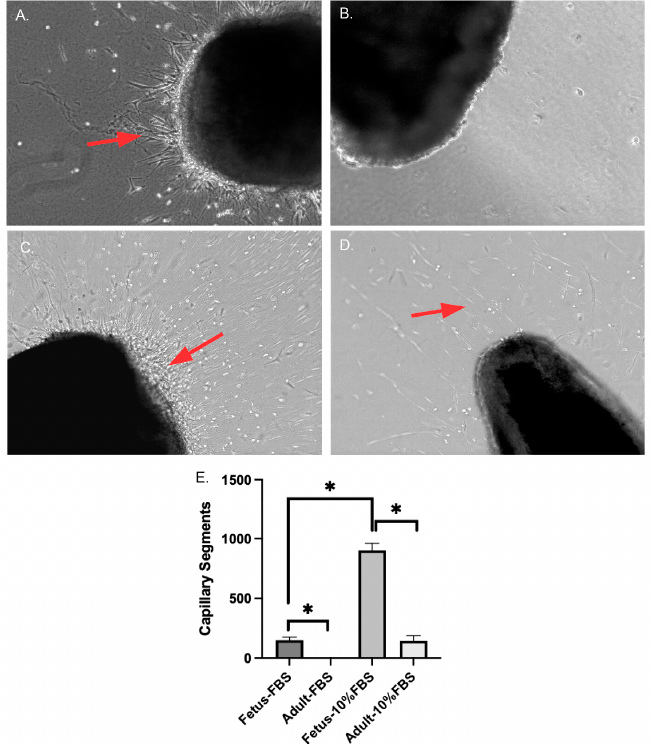
Figure 1. ( A ) Capillary and cell growth from carotid arterial segments from near-term ovine fetus grown in serum-free DMEM media. ( B ) No cell or capillary growths from carotid artery segments from adult ewe in serum-free DMEM media. ( C ) Robust cell and capillary growths in carotid segments from near-term ovine fetus grown in DMEM with 10% FBS. ( D ) Cell and capillary growth from an adult carotid artery segment in DMEM with 10% FBS. ( E ) The bar graph shows a higher amount of capillary segment growth in fetus carotid segments as compared to those from adult sheep. * Denotes p < 0.05, n = 5. All of the images shown in the figure were taken at 10 ×